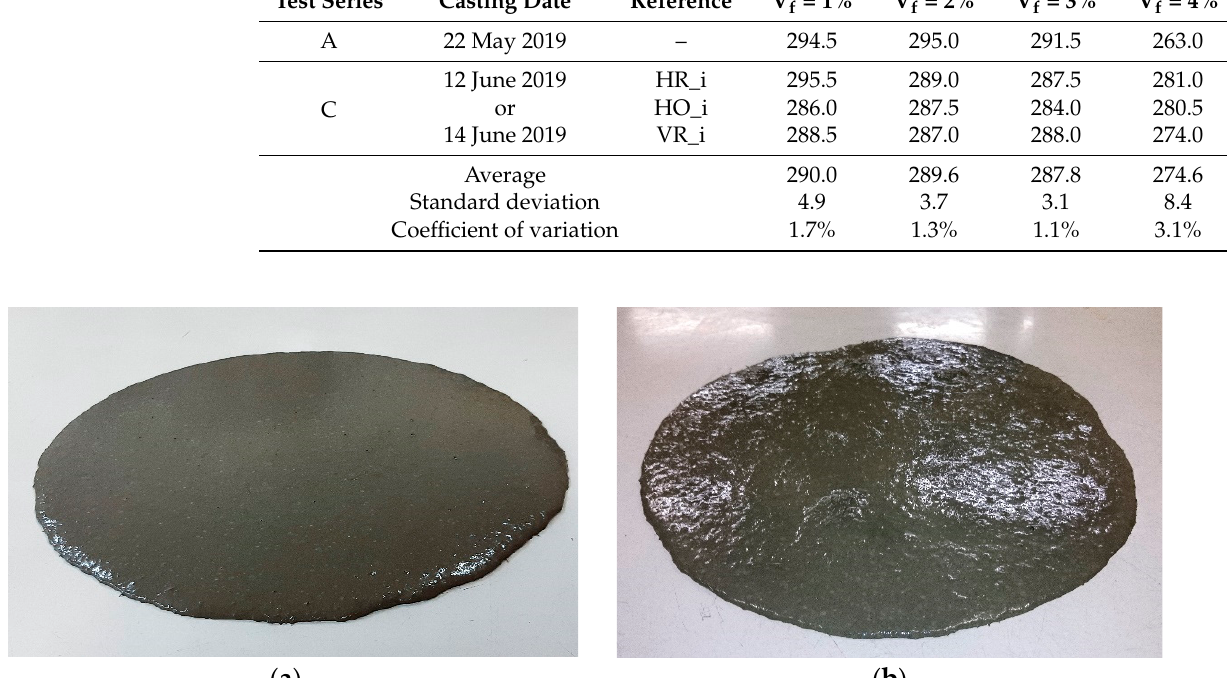
Figure 9. Final spread area of UHPFRC mixes with a fibre content of ( a ) 1% and ( b ) 4%.